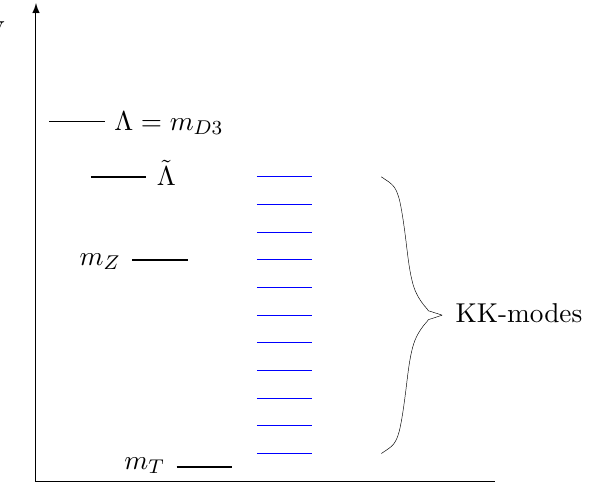
Figure 11 . Mass scales in the warped throat in the regime y UV >